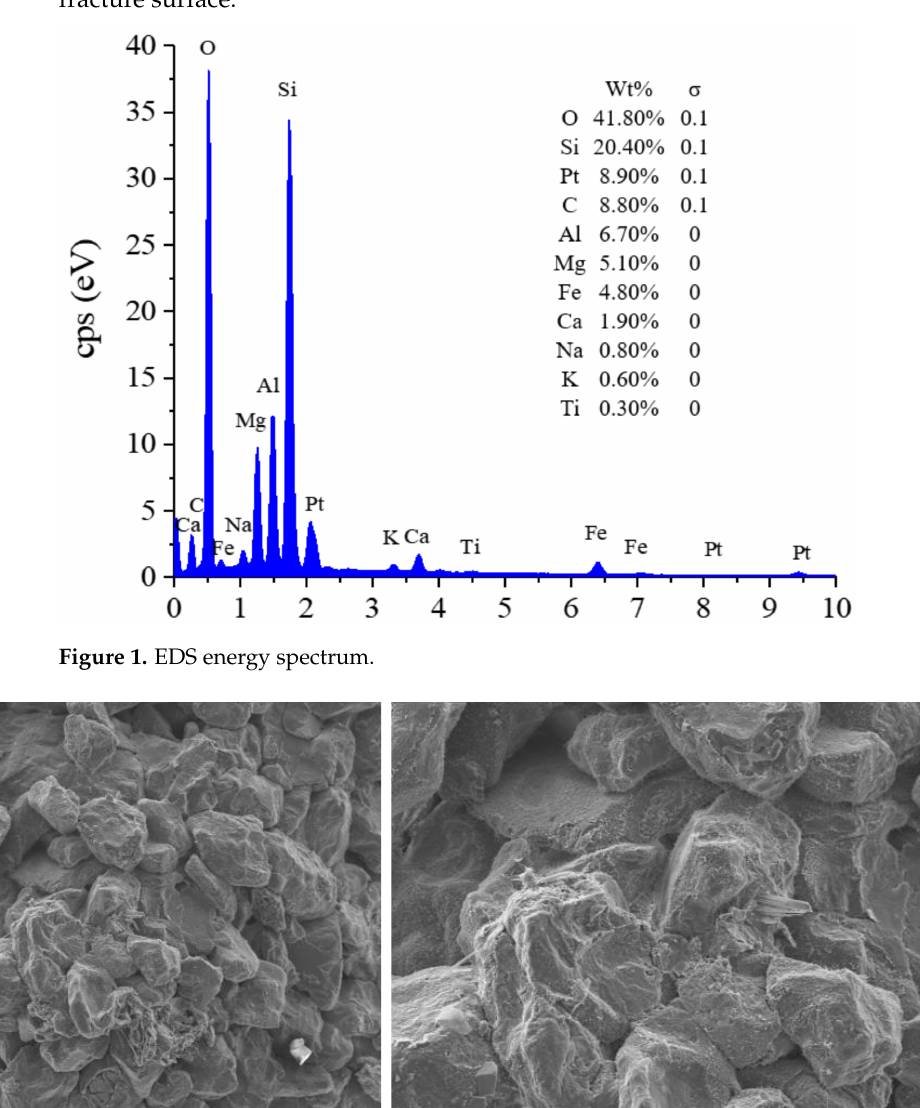
Figure 1. EDS energy spectrum.